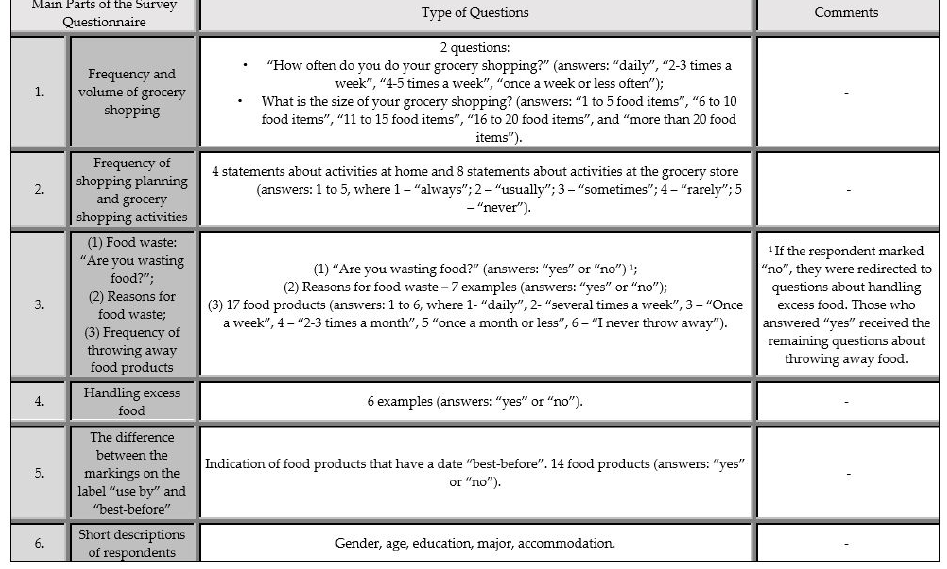
Figure 1. Division of the questionnaire.